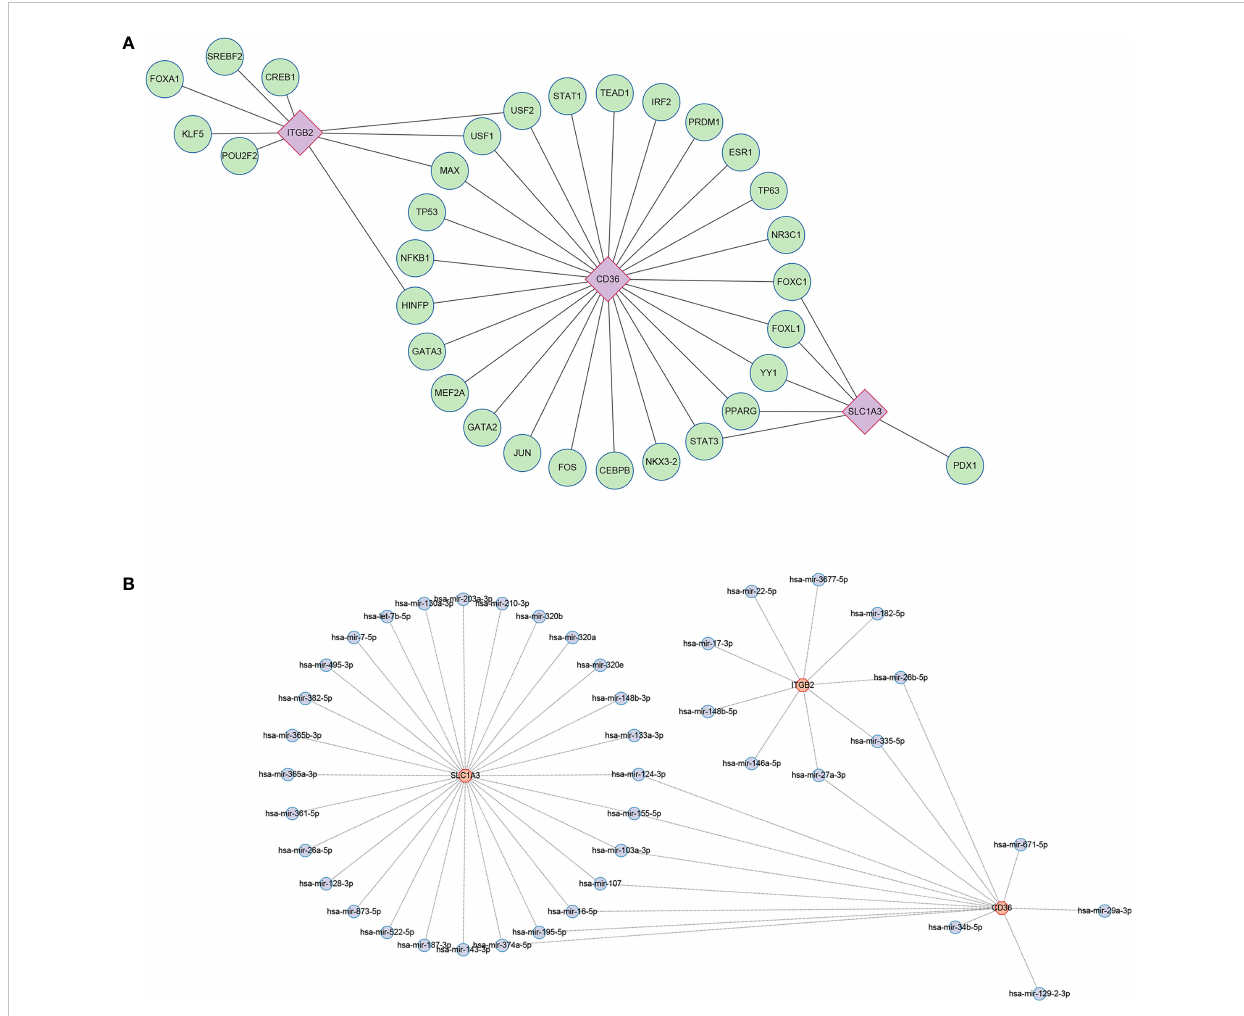
FIGURE 11 Regulatory network. (A) Interaction network of TFs and genes for the hub genes. (B) Network of interactions between miRNAs and the hub genes. TF, transcription factors; miRNA,